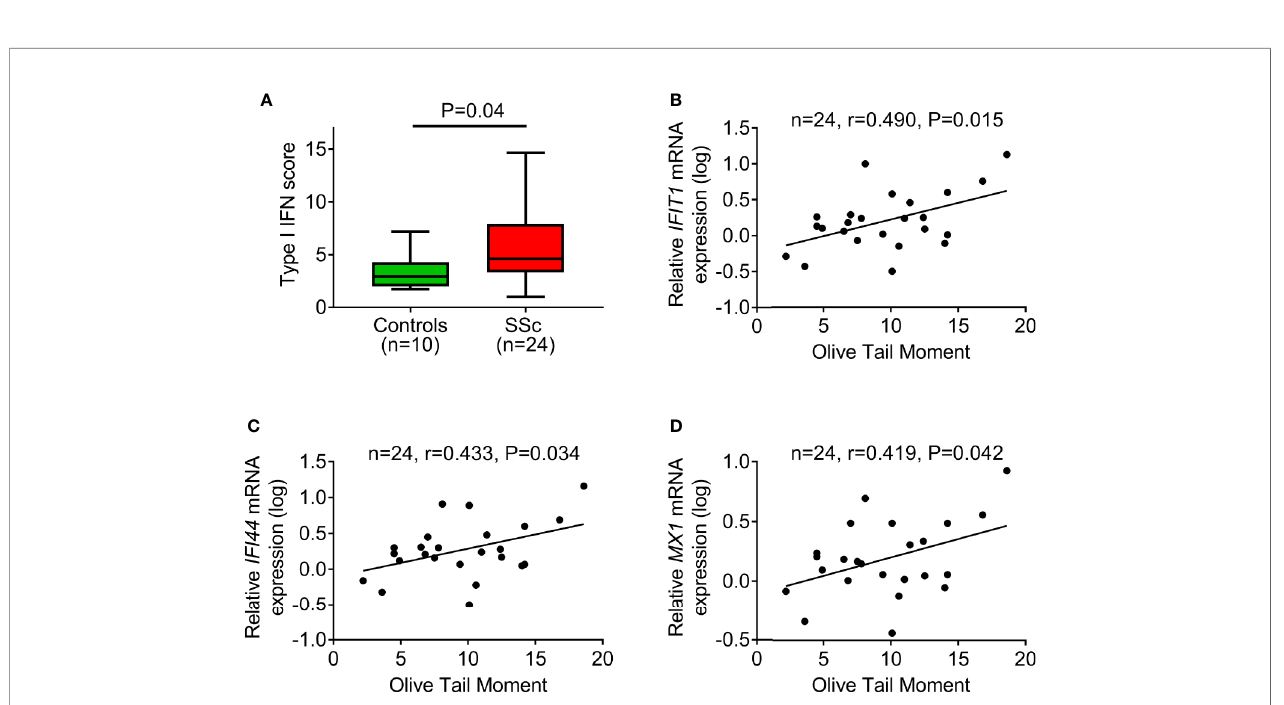
FIGURE 4 | DNA damage accumulation in association with type I IFN pathway activation. (A) Tukey boxplots showing the type I IFN score in PBMCs of controls ( n =10) and SSc patients ( n =24). For the calculation of type I IFN score, the relative mRNA expression of 3 type I IFN – induced genes (IFIT1, IFI44, and MX1) was measured with RT-qPCR. P -value is derived from Mann-Whitney U test. Scatterplots showing the relationship between endogenous DNA damage levels (Olive tail moment) and mRNA expression of the type I IFN-induced genes IFIT1 (B) , IFI44 (C) , and MX1 (D) in PBMCs of SSc patients. Correlation coef fi cients are derived from Pearson ’ s